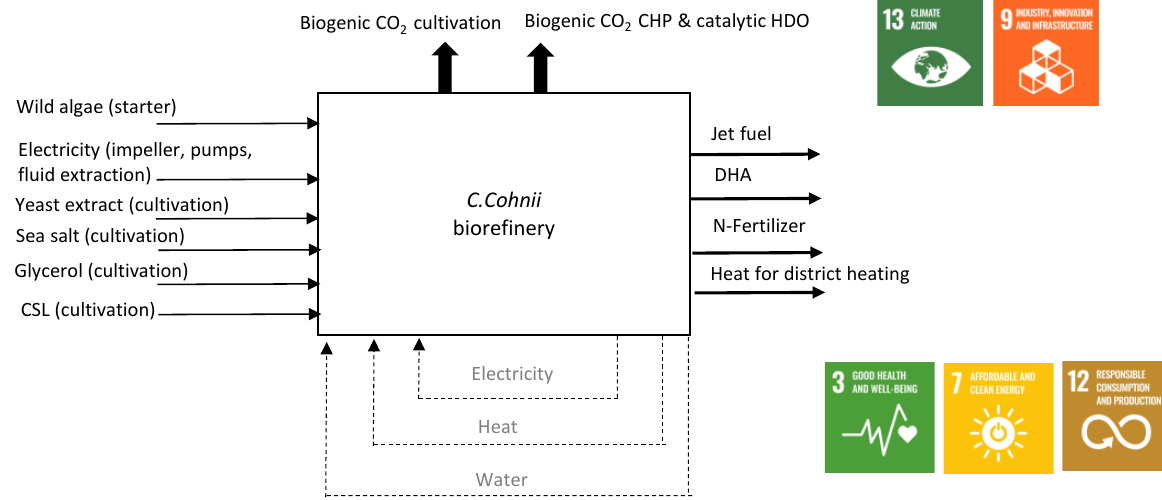
Figure 2. C. cohnii biorefinery and UNSDG relationship (own reasoning).